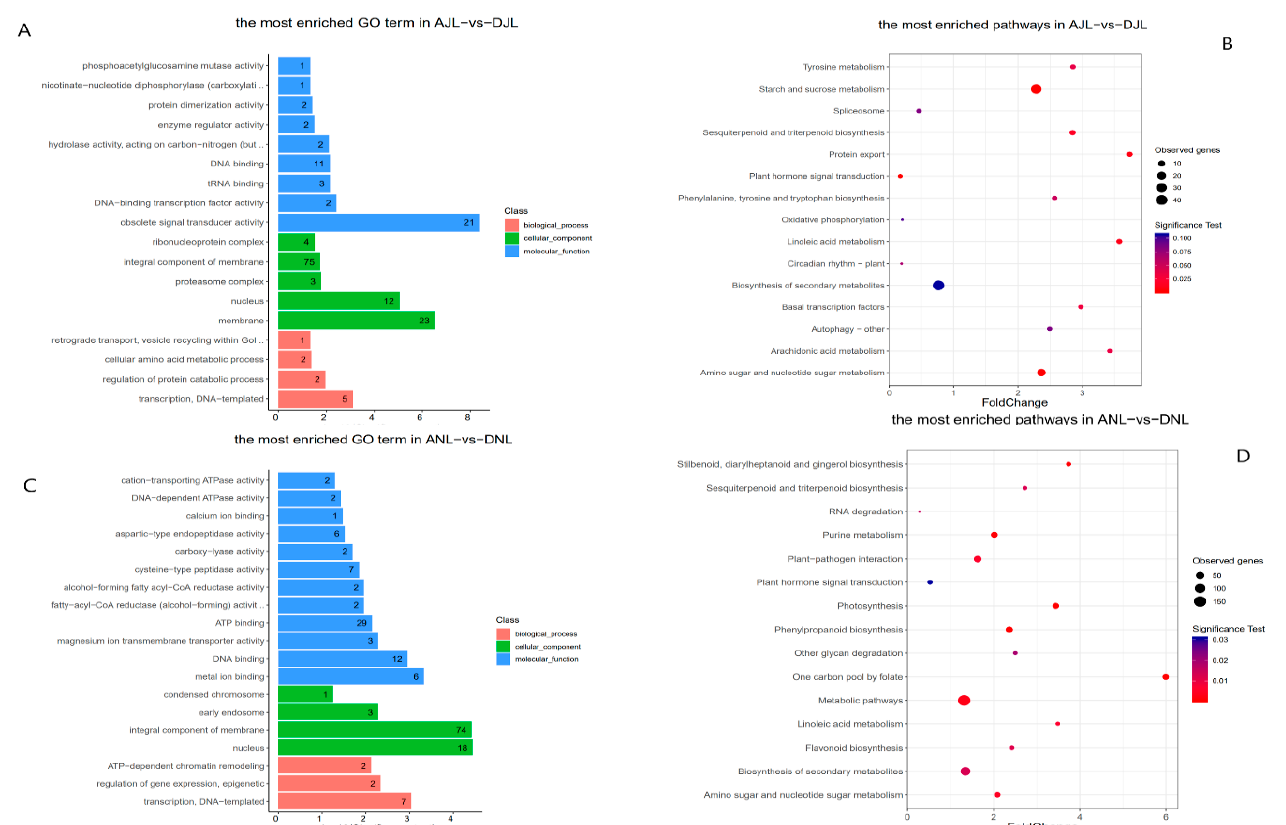
Figure 2. Enrichment analysis of methylated regions in cultivated and wild olives. ( A ) Most enriched gene ontology terms in methylated regions in both cultivated and wild olives leaf samples in July. ( B ) Most enriched KEGG pathways in methylated region in both cultivated and wild olive leaf samples in July. ( C ) Most enriched gene ontology terms in methylated region in both cultivated and wild olives leaf samples in November. ( D ) Most enriched KEGG pathways of methylated regions in both cultivated and wild olives leaf samples in November. ANL: Ayvalik November fruit, DNL: wild November fruit. AJL: Ayvalik July fruit, DJL: wild July fruit, where Delice is the Turkish name of the wild Oleaster.